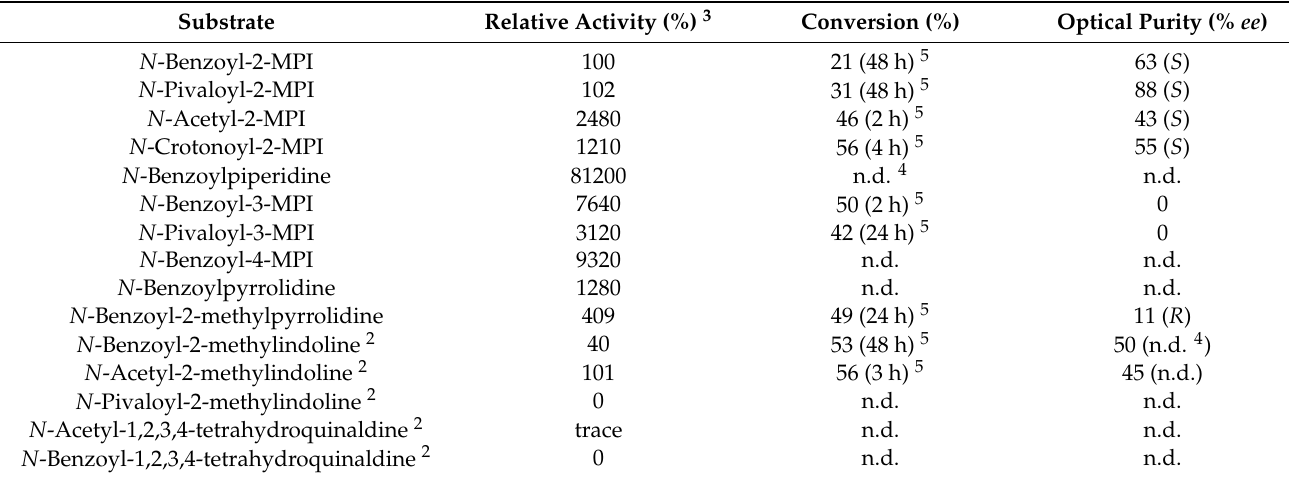
Table 1. Substrate specificity of SHA 1 .